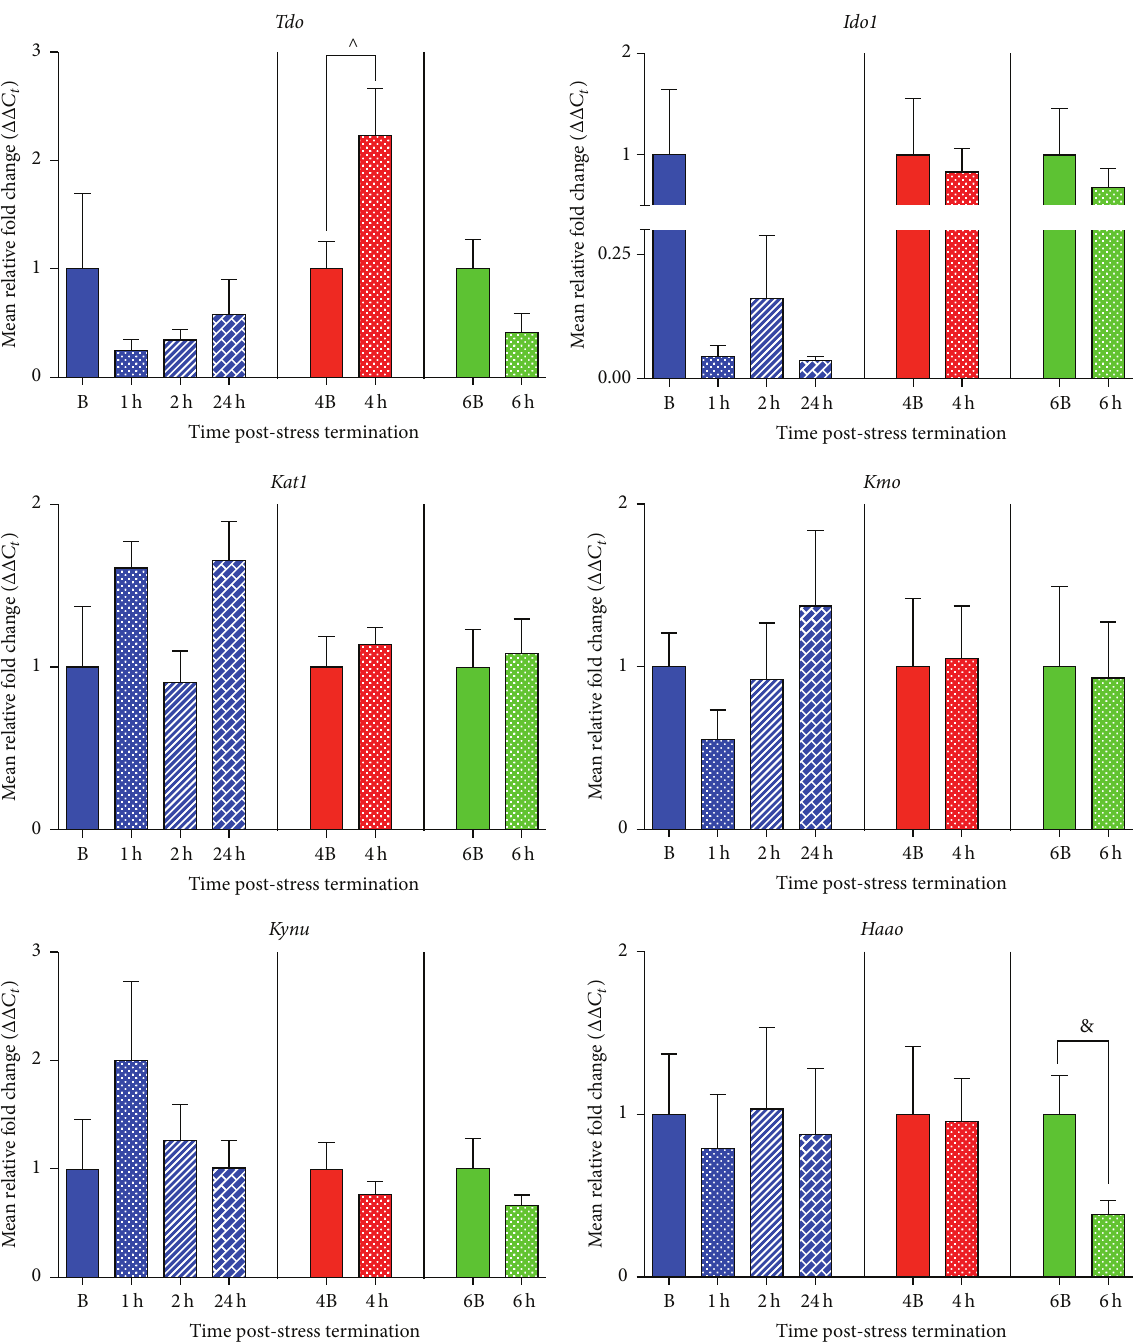
Figure 4: Effects of acute restraint stress on enzymes regulating the kynurenine pathway in the hypothalamus. mRNA expression levels of tryptophan 2,3-dioxygenase ( Tdo ), indoleamine 2,3-dioxygenase 1 ( Ido1 ), kynurenine aminotransferase ( Kat1 ), kynurenine 3-monooxygenase ( Kmo ), kynureninase ( Kynu ), and 3-hydroxyanthranilate 3,4-dioxygenase ( Haao ) were examined 1–24 h post-stress termination. All data are represented as means ± SEM (𝑛 = 3 – 6/ group ) . ∧ 𝑝 < 0.05 (in comparison to the 4B group); & 𝑝 < 0.05 (compared to 6B group).